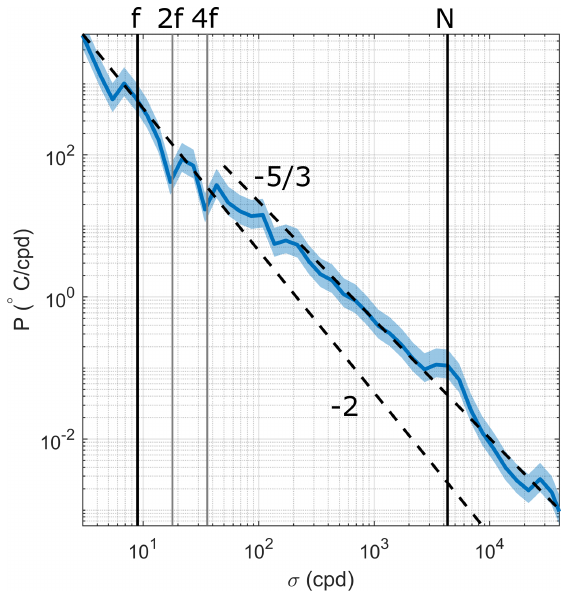
Figure 10. Directly observed internal stress divergence from mi- crostructure profiler ( ∂τ/∂z ) compared to control-volume-derived residual internal stress divergence ( ∂τ r /∂z ). The terms are averaged over each layer: surface (pink), interface (dark blue) and ambient (light blue); and over each 1km region from the tailrace discharge point: 0–1km (square), 1–2km (diamond) and 2–3km (circle). The error bars indicate 1 standard deviation for each term.